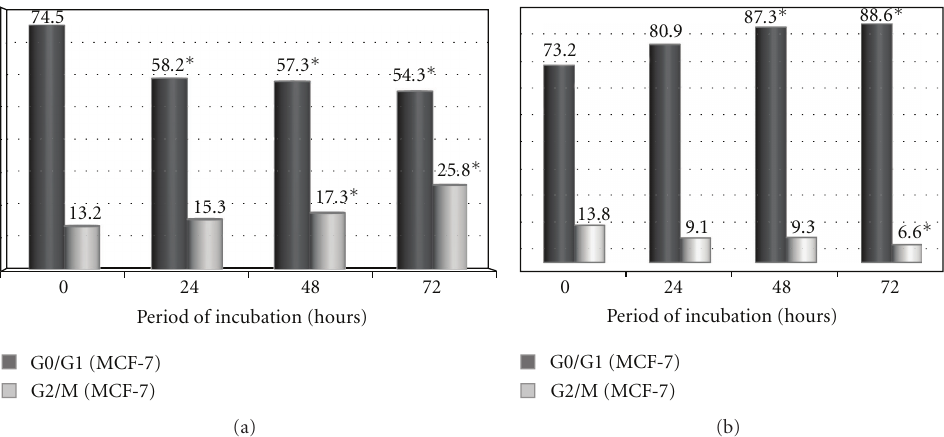
Figure 4: Histogram showing the proportion of cells in G0/G1 and G2/M phases of the cell cycle at di ff erent periods of treatment with EOea and EOace. (a)MCF-7 cells treated with EOea; (b) MCF-7 cells treated with